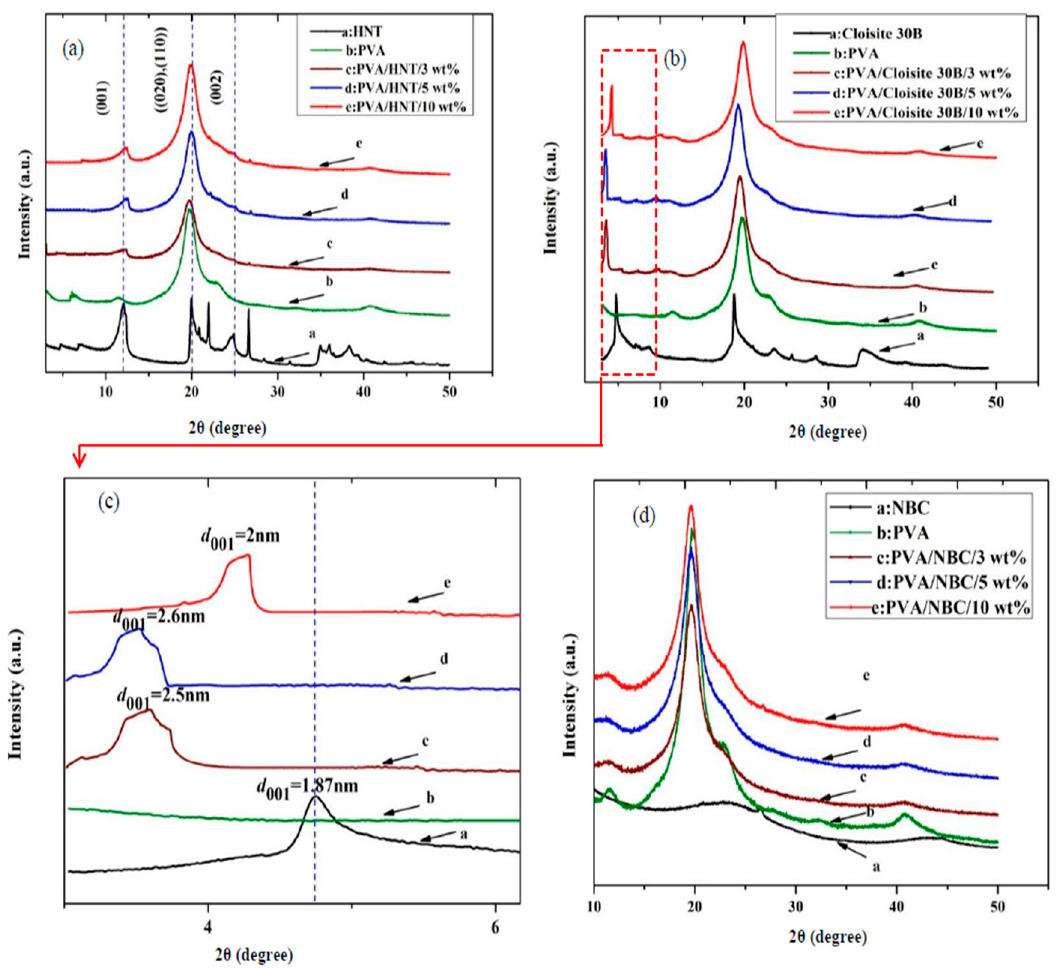
Figure 3. XRD patterns for PVA bionanocomposites reinforced with ( a ) HNTs, ( b,c ) Cloisite 30B clays with both wide and small diffraction angles, respectively, and ( d ) NBCs.